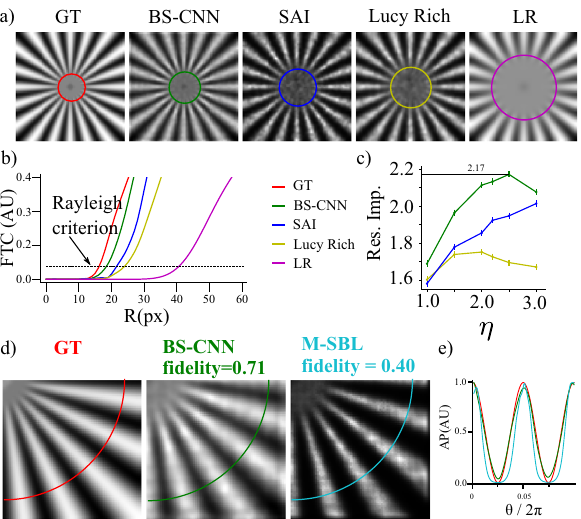
Figure 2. Resolution measurement: ( a ) A Siemens star of density ρ = 1 + cos 20 θ (field of view is 13 times d PSF ). From left to right: the ground truth GT, the LR deconvolved with BS-CNN, with SAI, and with Lucy Richardson and the low resolution LR. All the deconvolution have been obtained with N = 1000 ; The last frame is the Low-Resolution one (LR) obtained from the GT convolving it with the PSF of FHWM d PSF ( η = 2.5 ). The radii of circles highlighted in the figure correspond radius at which the Siemens star rays are resolved. ( b ) The Fourier transform contrast FTC versus the radius R . The dashed line represents the Rayleigh criterion. (c) Resolution improvement of the BS-CNN, Lucy Richardson and SAI as a function of η with error-bars. The maximum resolution improvement is 2.17. (d) From left to right: quarter of the Siemens star for the GT, BS-CNN, and M-SBL ( e ) azimuthal profiles from ( d